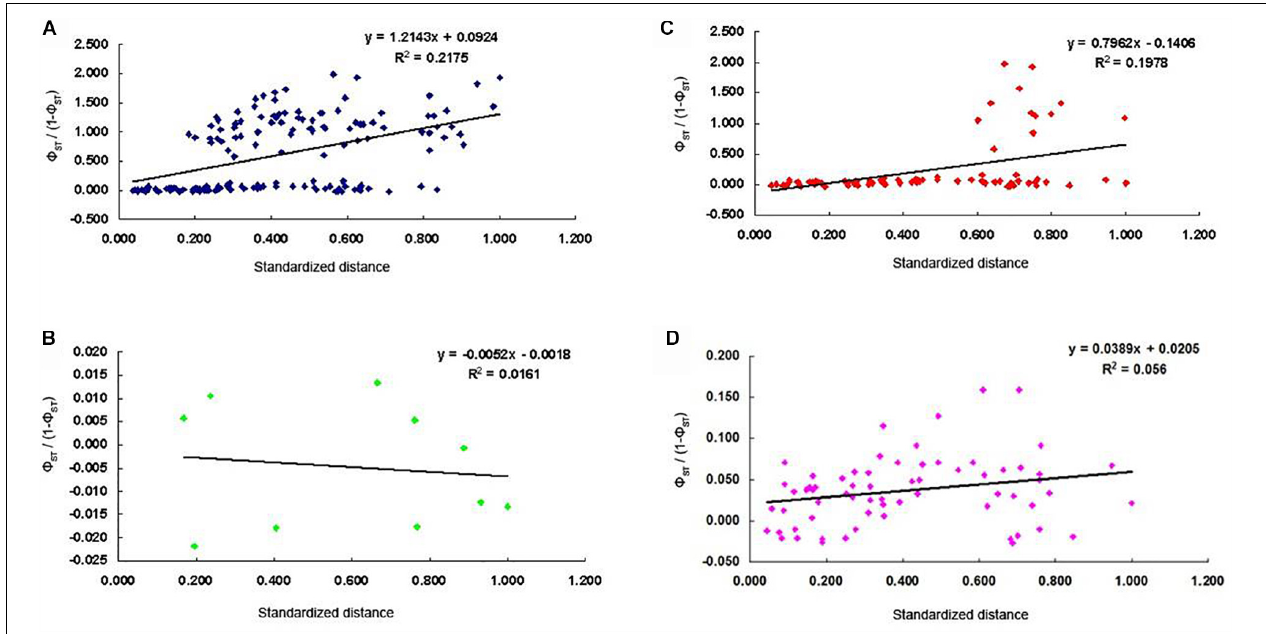
FIGURE 5 | Corelation between pairwise differentiation ( (cid:56) ST ) and standardized geographic distance for C. nasus ; (A) , all populations ( R 2 = 0.2175, P = 0.001; B ), five populations in the middle reaches of the Yangtze River ( R 2 = 0.0161, P > 0.05; C ), all populations except the five populations from the middle reaches of the